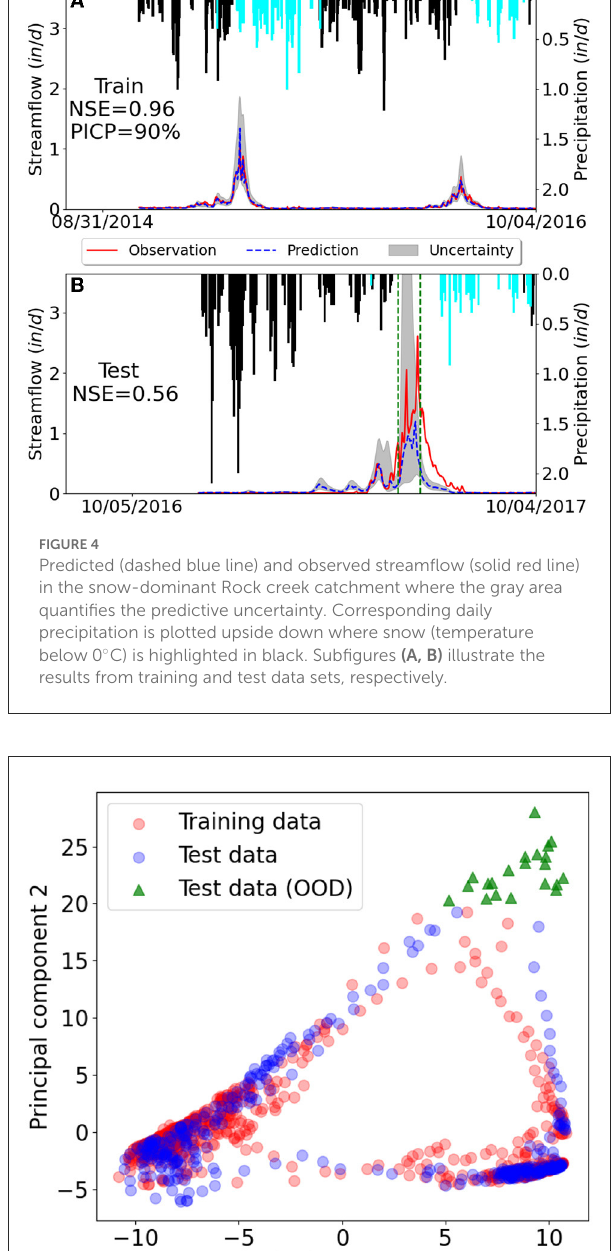
green dashed lines are remarkably high, and indeed this highly uncertain region has a larger prediction error where the model- predicted streamflow deviates from the observations the most.